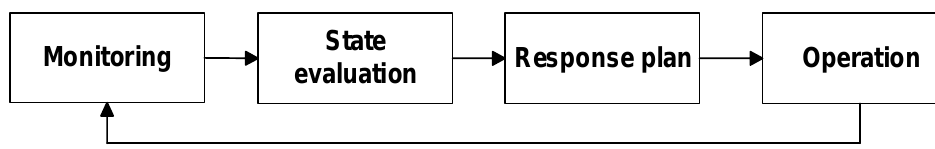
Figure 2. Operator’s cognitive behavioral process.